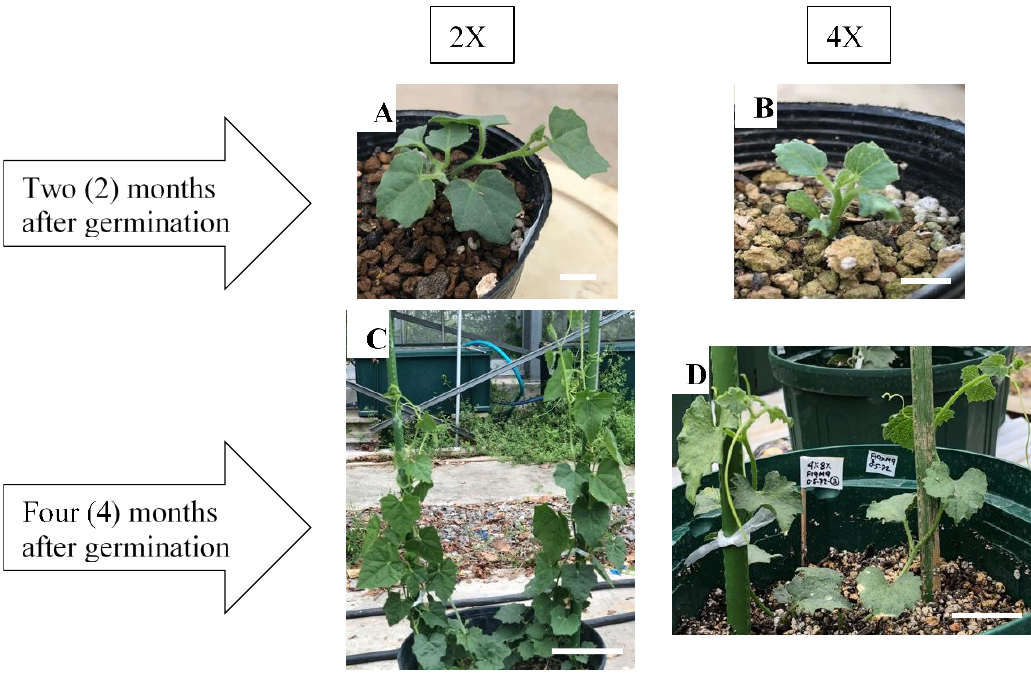
Figure 4. The morphological variation of the diploid and tetraploid pointed gourd seedlings that survived in 2018. ( A ), ( C ): diploid (2x), ( B ), ( D ): tetraploid (4x). Bars indicate 1 cm in A and B and 5 cm in C and D.